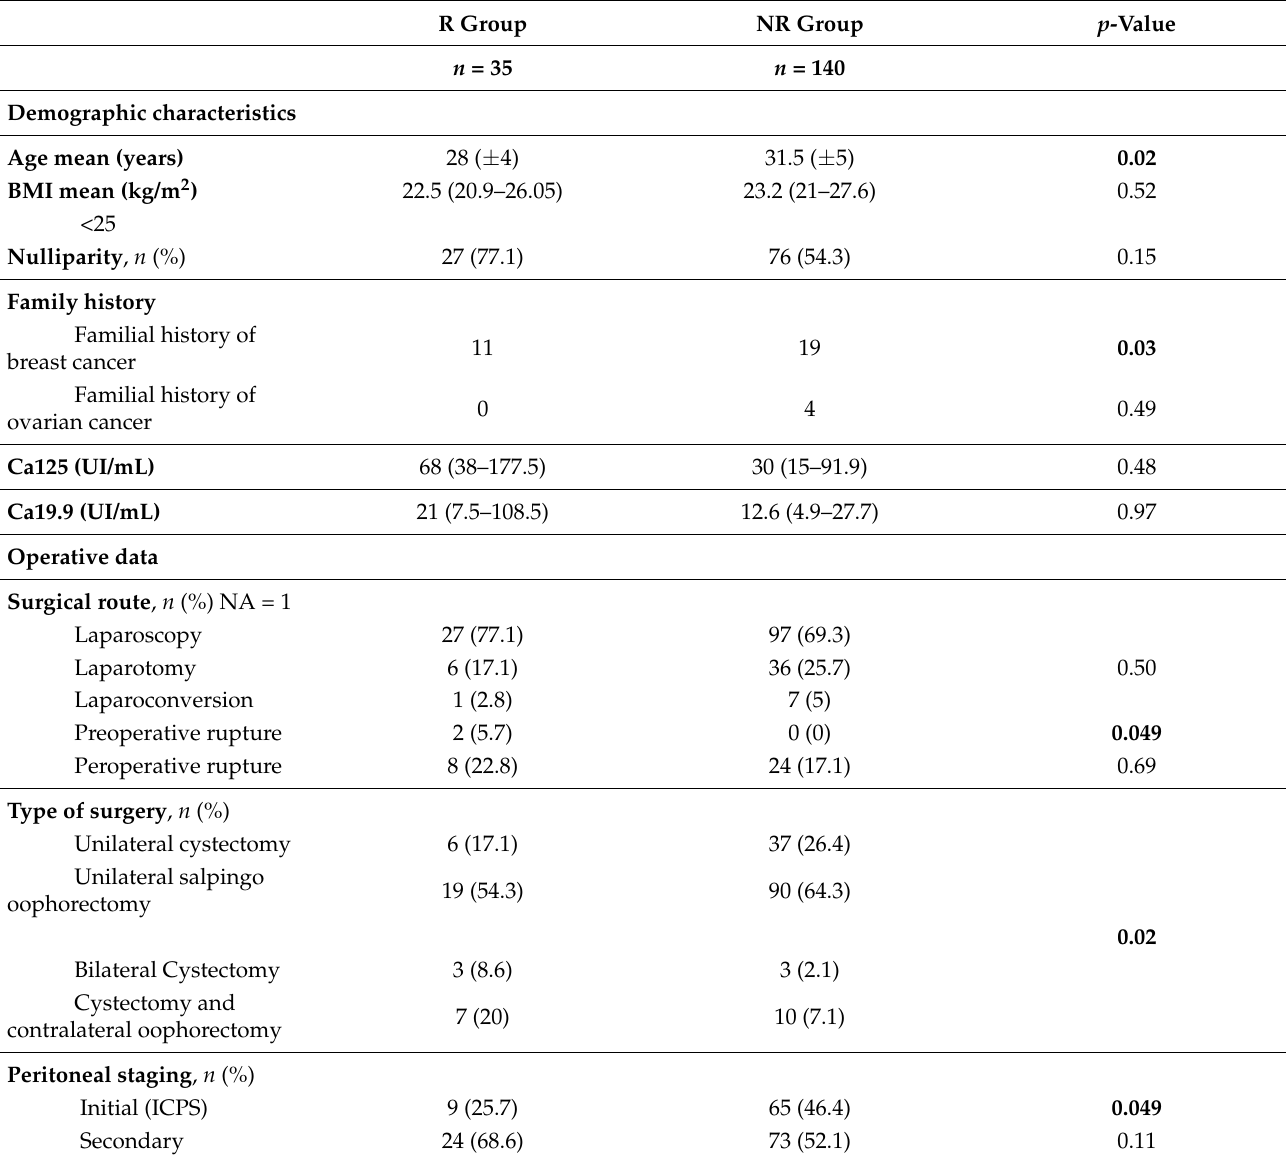
Table 3. Epidemiological and surgical characteristics of the population by recurrence